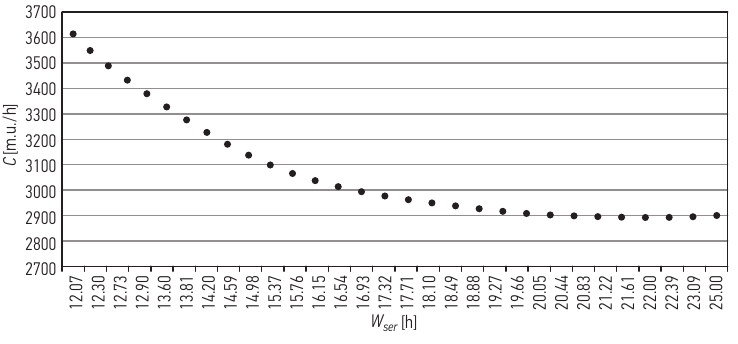
W Fig. 2. Pareto front of costs C and service time W ser